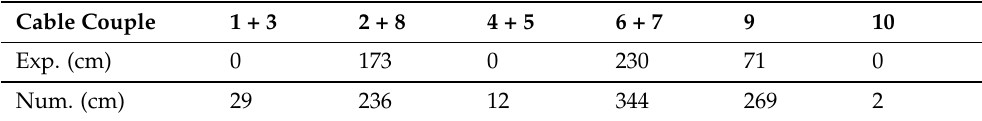
Table 8. Brake elongations by cable number grouping cable by pairs in the y direction for the lateral